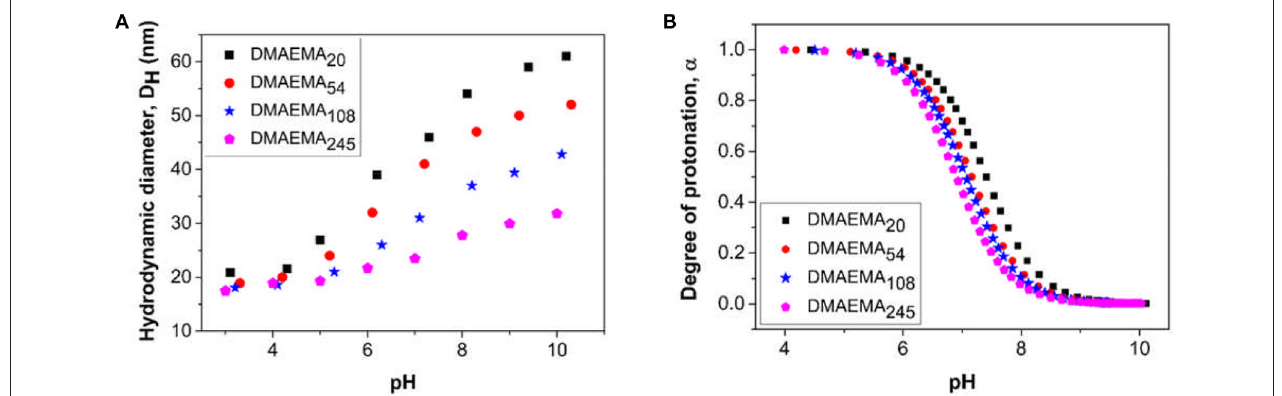
FIGURE 2 | Changes in (A) hydrodynamic diameter and (B) degree of polymer protonation as a function of solution pH for the four diblock copolymers prepared at a concentration of 1,000 ppm (above the CMC). The polymer solutions are prepared in the presence of 0.01M KNO 3 , ( T = 25 ◦ C). The p K a of the copolymers obtained are; DMAEMA 20 = 7.41, DMAEMA 54 = 7.16, DMAEMA 108 = 7.08, and DMAEMA 245 = 6.92.